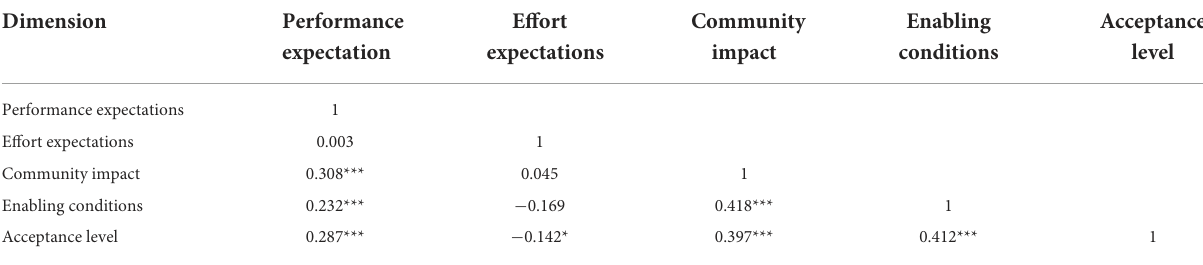
TABLE 4 Correlation coefficients of teachers’ acceptance of robotics education and its various influencing factors. Dimension